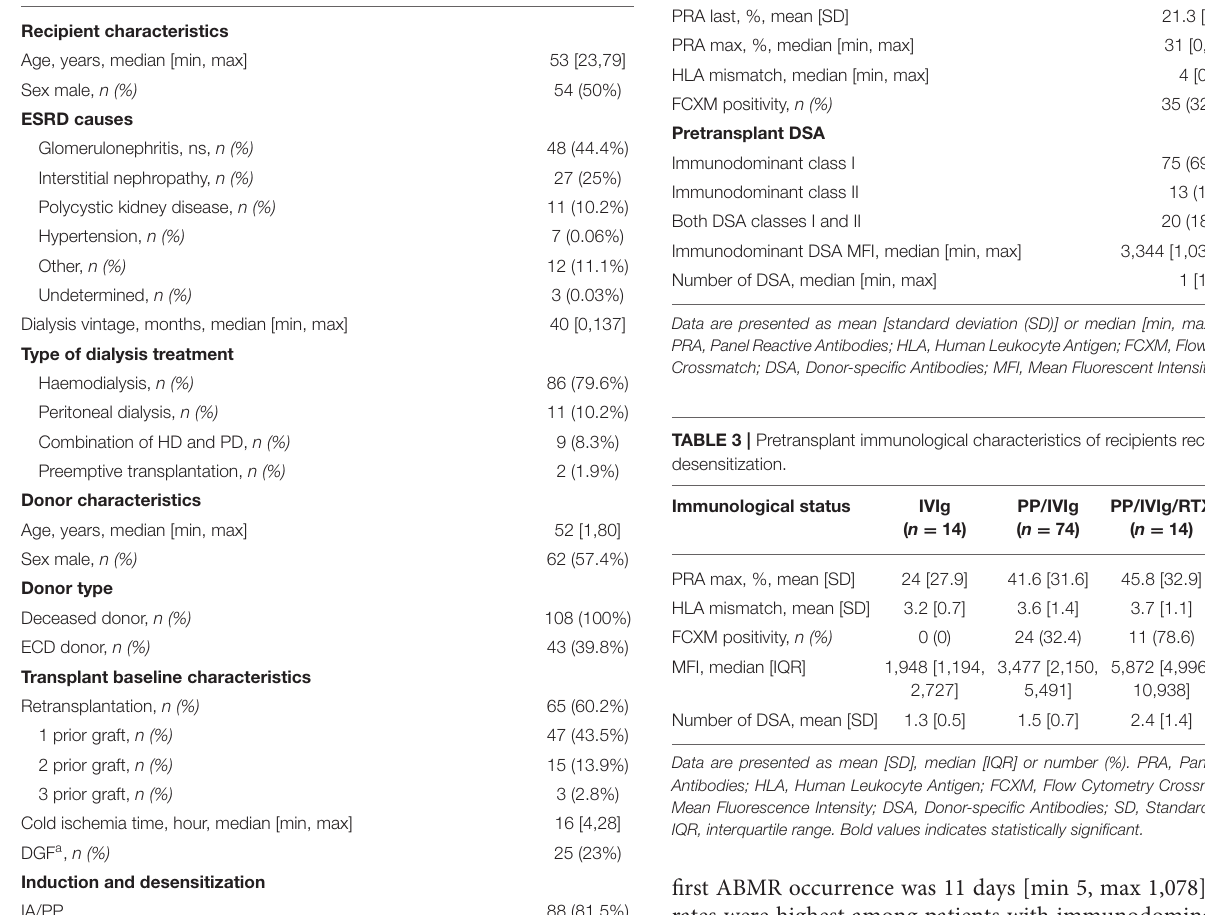
TABLE 1 | Baseline demographic and clinical characteristics of the study population. Patient characteristics ( n = 108)